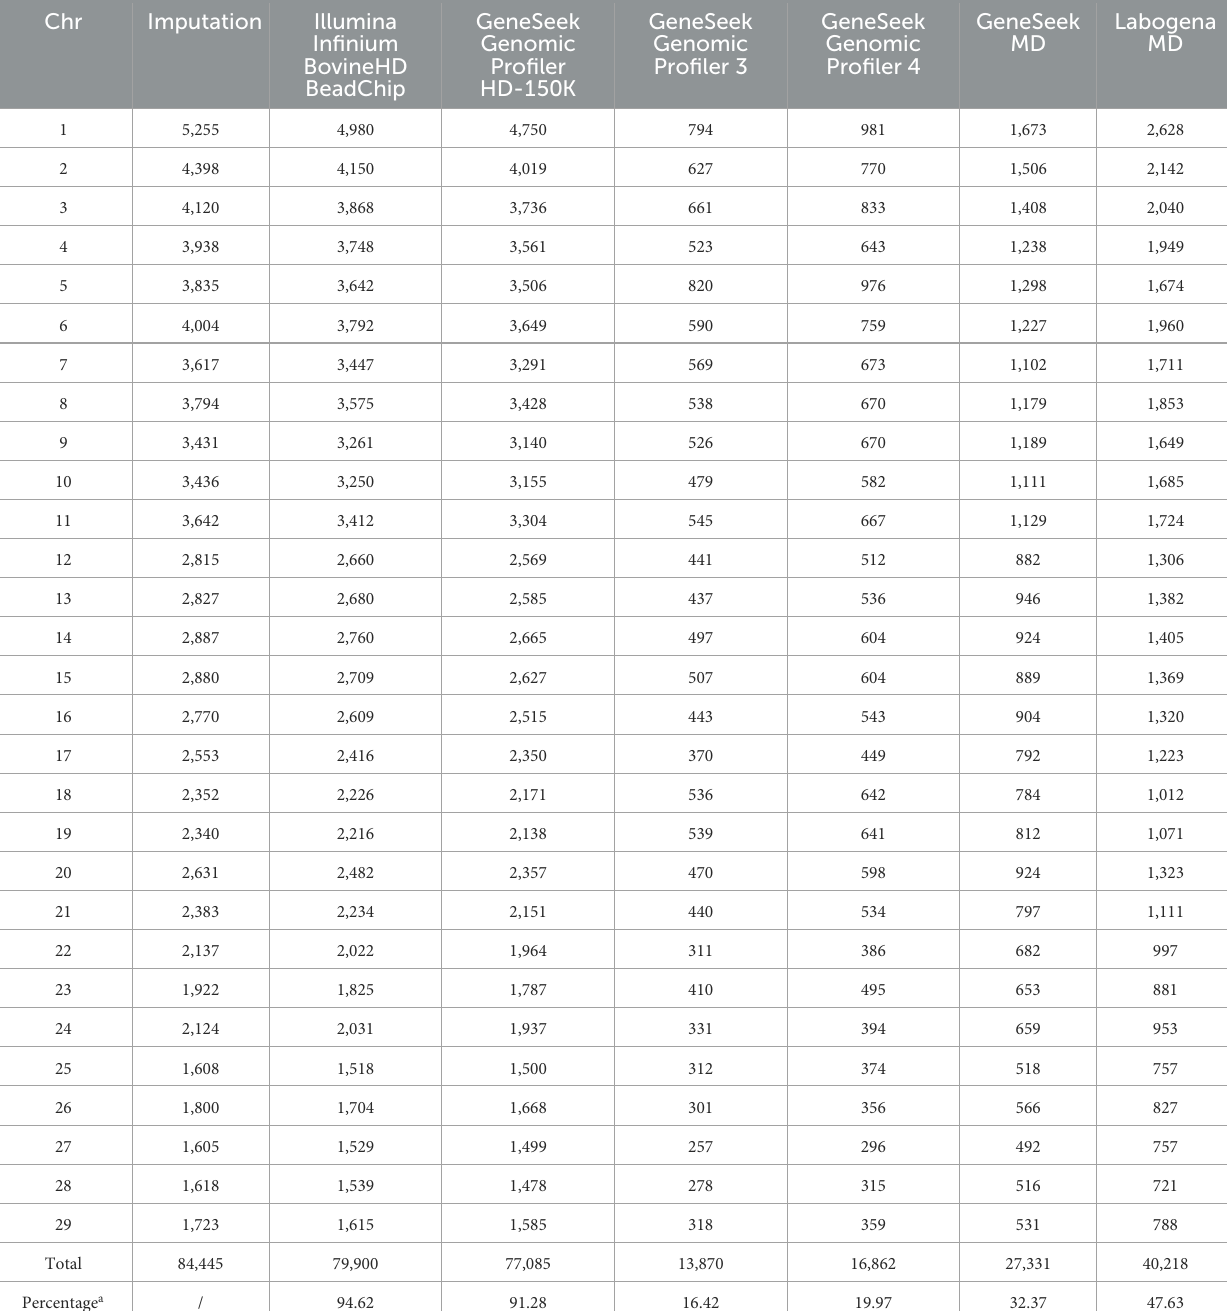
TABLE 1 Number of single nucleotide polymorphisms per chromosome in the imputed dataset and each genotype panel.